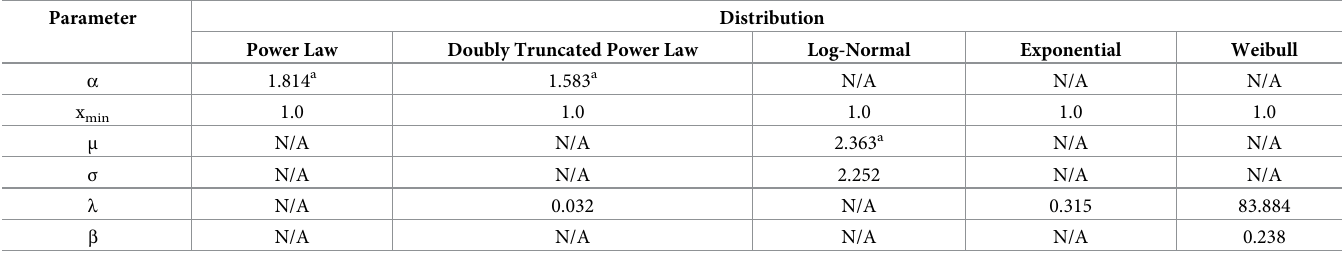
Table 1. Summary of calculated parameters for each